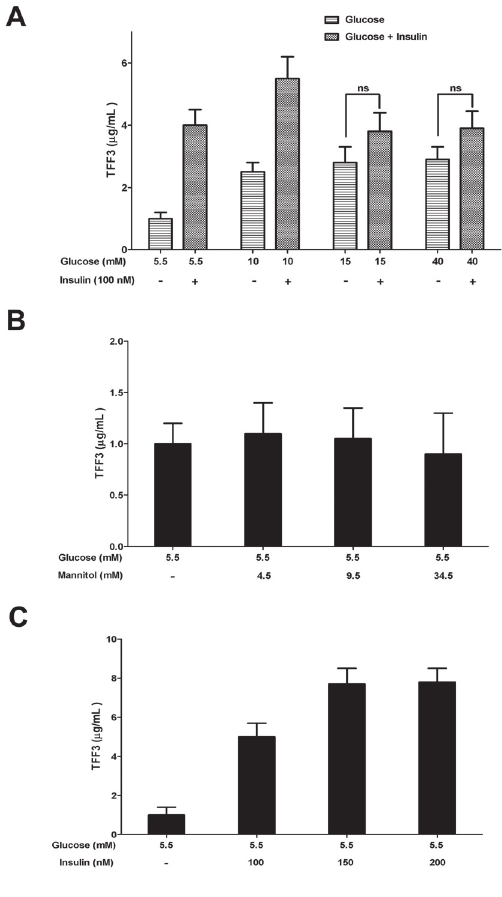
FIGURE 1. TFF3 levels in cell culture supernatants: HT-29 cells were grown in 6-well plates at 50% con fl uence and serum-starved for 24 h. Cells were treated with different glu- cose concentrations (5.5 mM, 10 mM, 15 mM, and 40 mM), for 6 h. In some experiments, HT-29 cells were treated with insulin ranging from 100 nM to 200 nM for 6 h. Afterwards, culture supernatants of HT-29 were collected and centrifuged at 1000×g for 15 min at 4ºC, the proteins were precipitated by trichloroacetic acid (TCA) and TFF3 levels was measured by ELISA. (A) Intestinal HT-29 cells were treated with increasing concentrations of glucose in the absence or presence of 100 nM insulin. (B) HT-29 cells were treated with 5.5 mM glucose and increasing concentrations of mannitol for 6 h. (C) Intes- tinal cells were treated with 5.5 mM glucose and increasing concentrations of insulin for 6